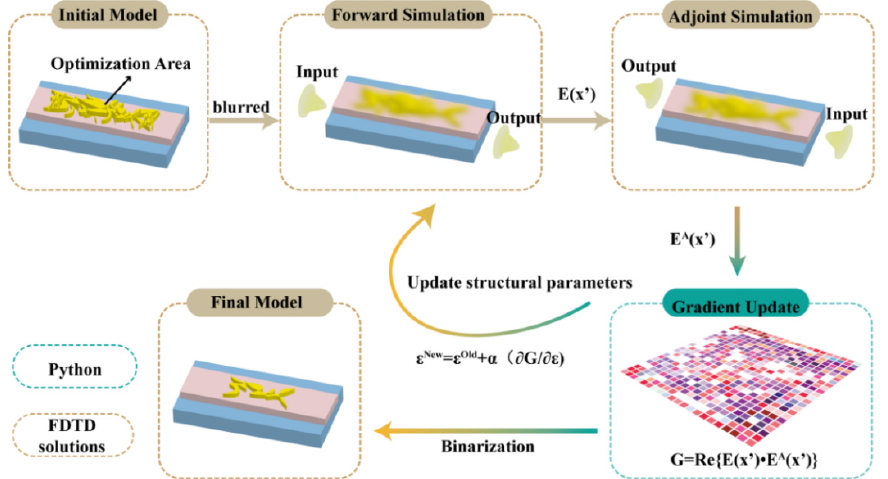
Figure 2. Design flow diagram.